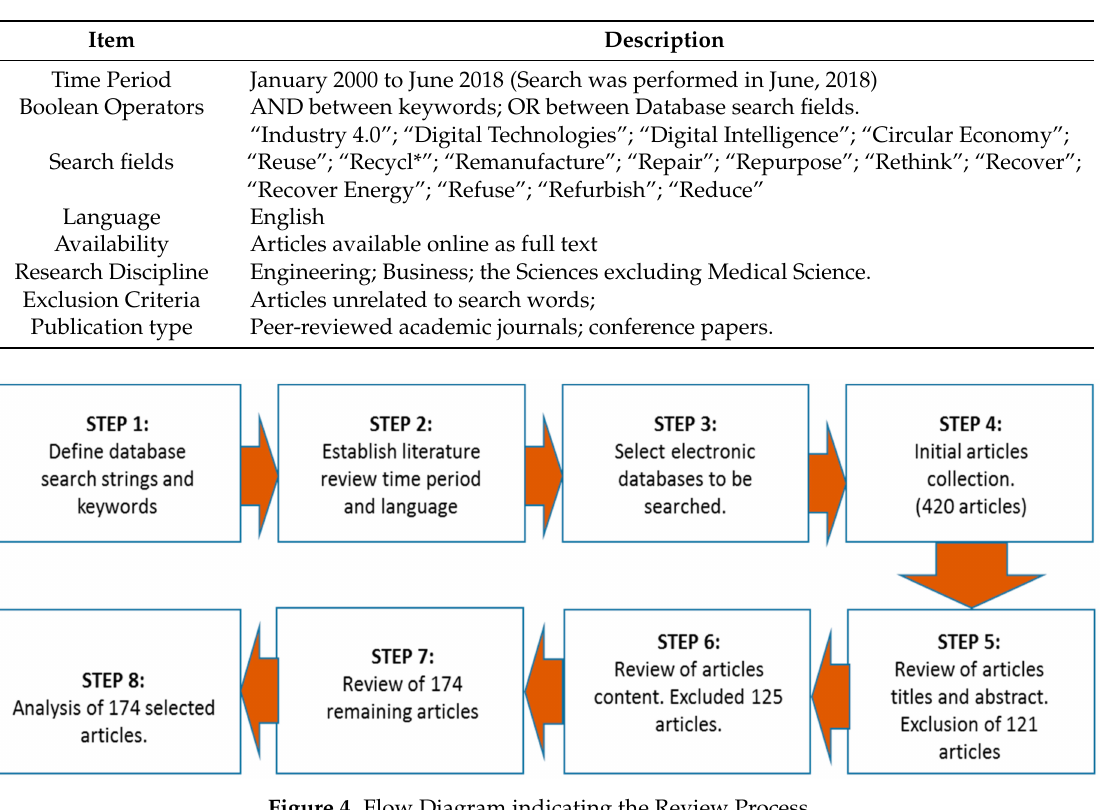
Table 2. Literature Review Protocol.